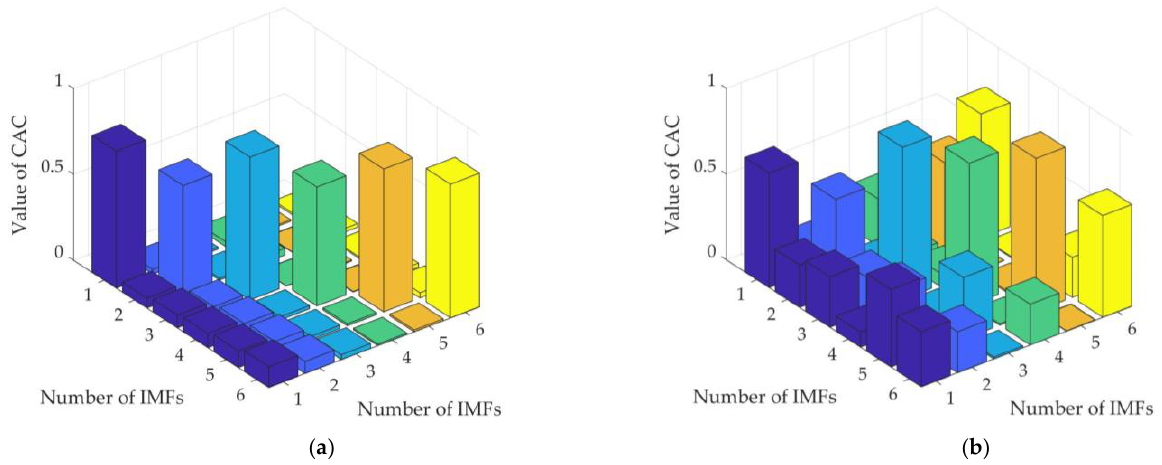
Figure 20. ( a ) The CAC values of Segment 1 in the current monitoring stage. ( b ) The CAC values of Segment 2 in the current monitoring stage.